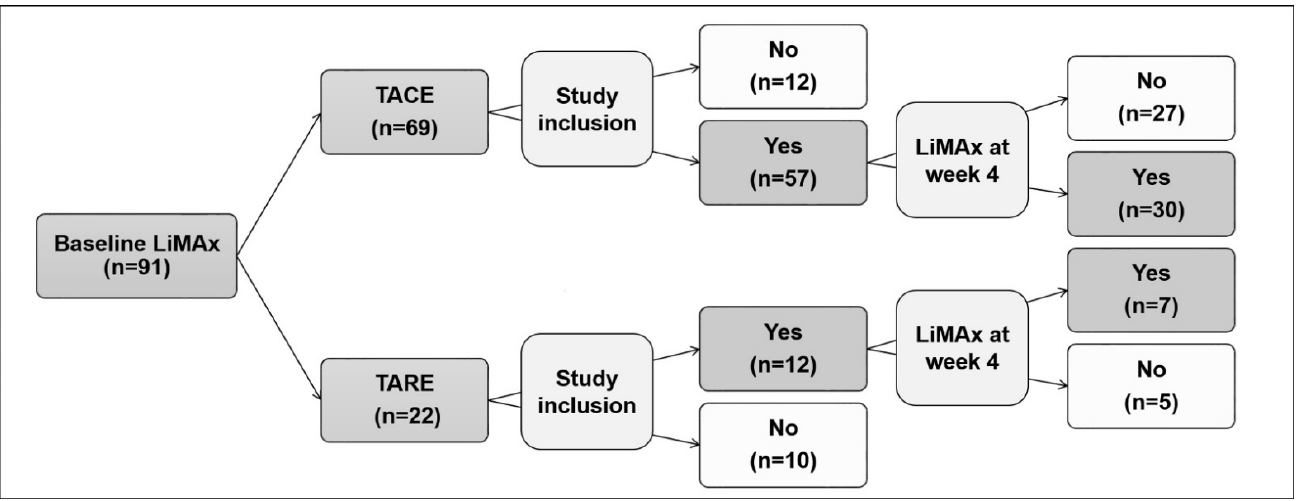
Figure 1. Patients included in the present study. A total of 12 patients with TACE and 10 patients with TARE were excluded because of concomitant cancer diseases such as